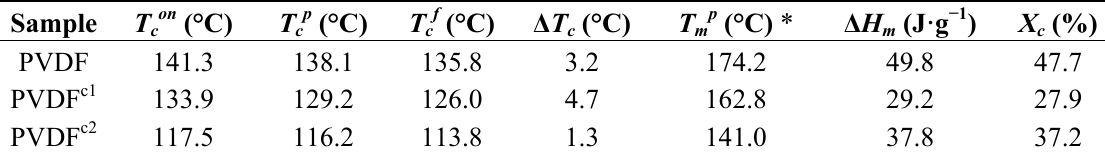
Table 1. DSC crystallization results of homer- and co-PVDF crystallizing from the melt at a cooling rate of 2.5